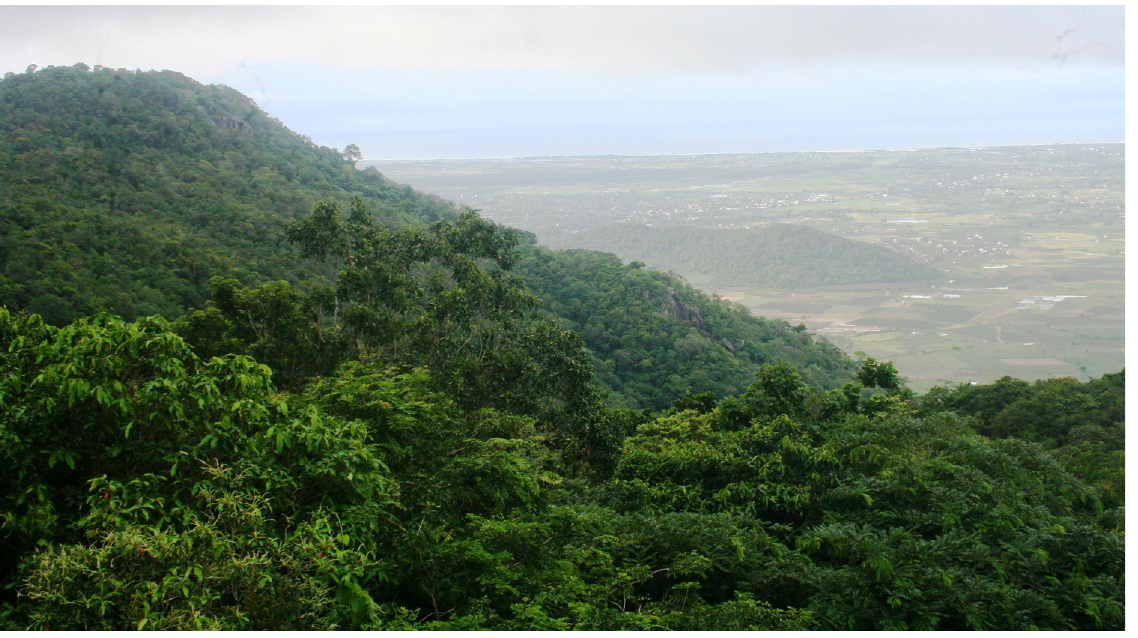
Fig. 9. Habitat of Cyrtodactylus chungi sp. nov. in Ta Kou Nature Reserve, Binh Thuan Province. Photo C.T.